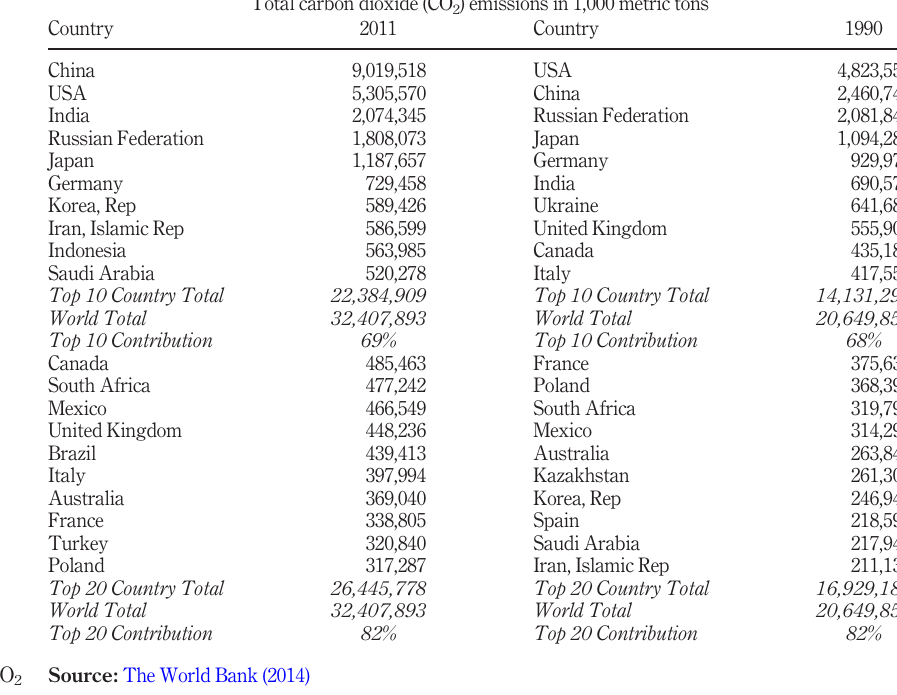
producing most CO